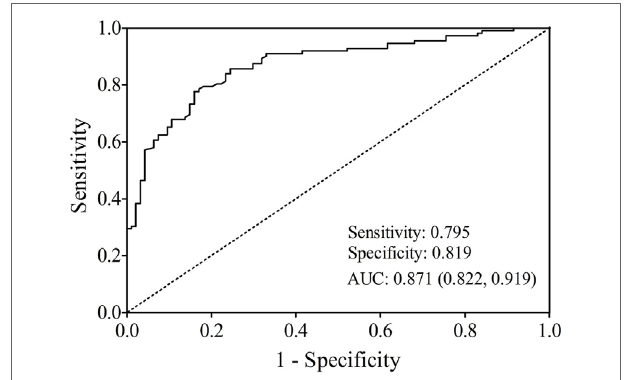
FigUre 4 | Receiver operating characteristic plot for the miRNA panel (let-7b, miR-142, and miR-144) discriminating type 2 diabetes